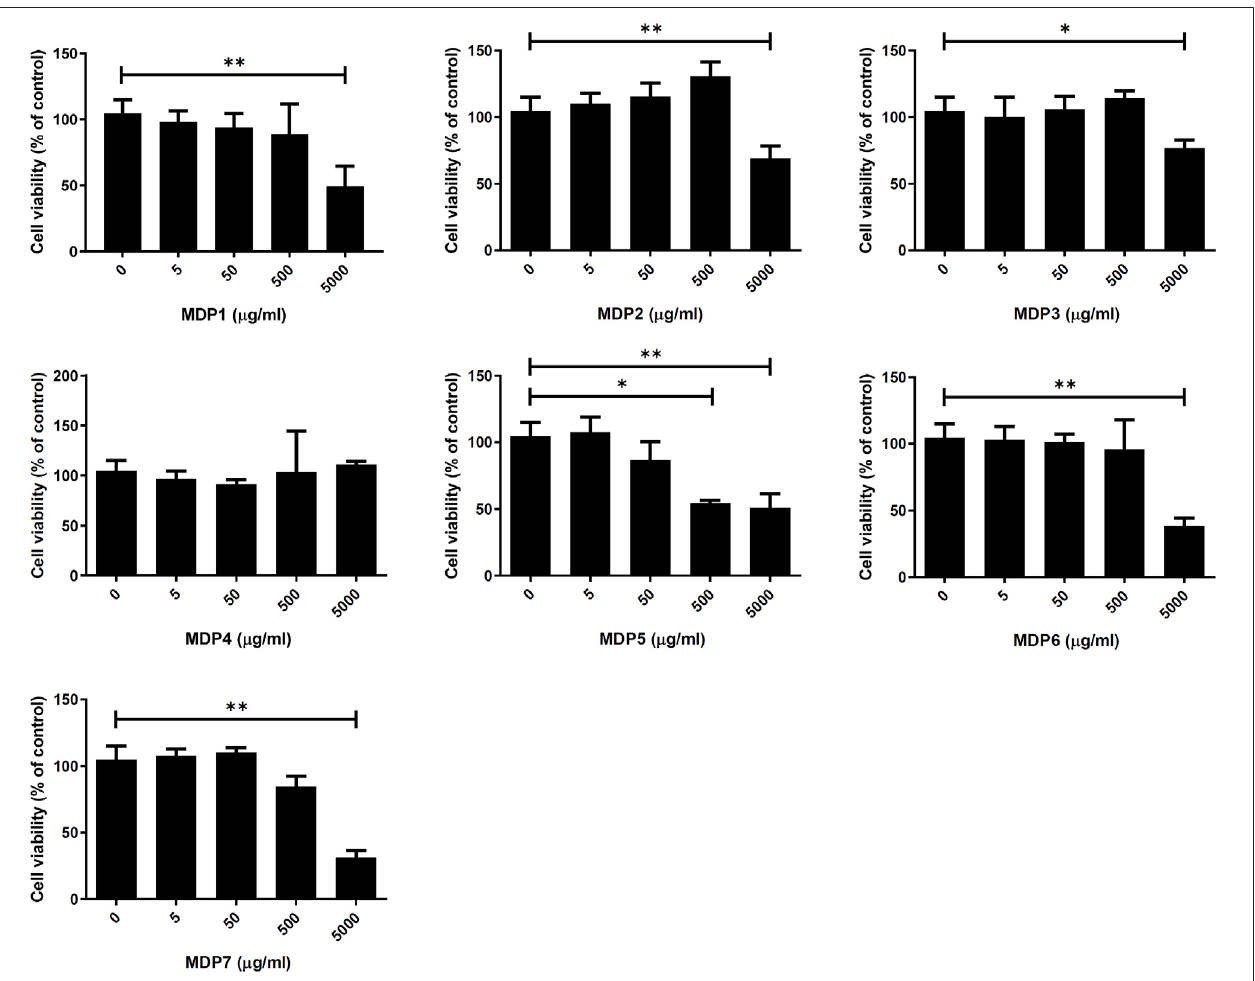
FIGURE 3| Cell toxicity ofMDP fractions. THP-1 cells were treated with different concentrations ofindividual MDP fractions and stimulated with Pam3CSK4. After 24 h of stimulation, THP-1 cell viability was determined by the MTS assay. Data are the mean ± S.D. ( n (cid:1) 3 – 5). ** p < 0.01, *** p < 0.001. Data were analyzed using the Student ’ s t -test